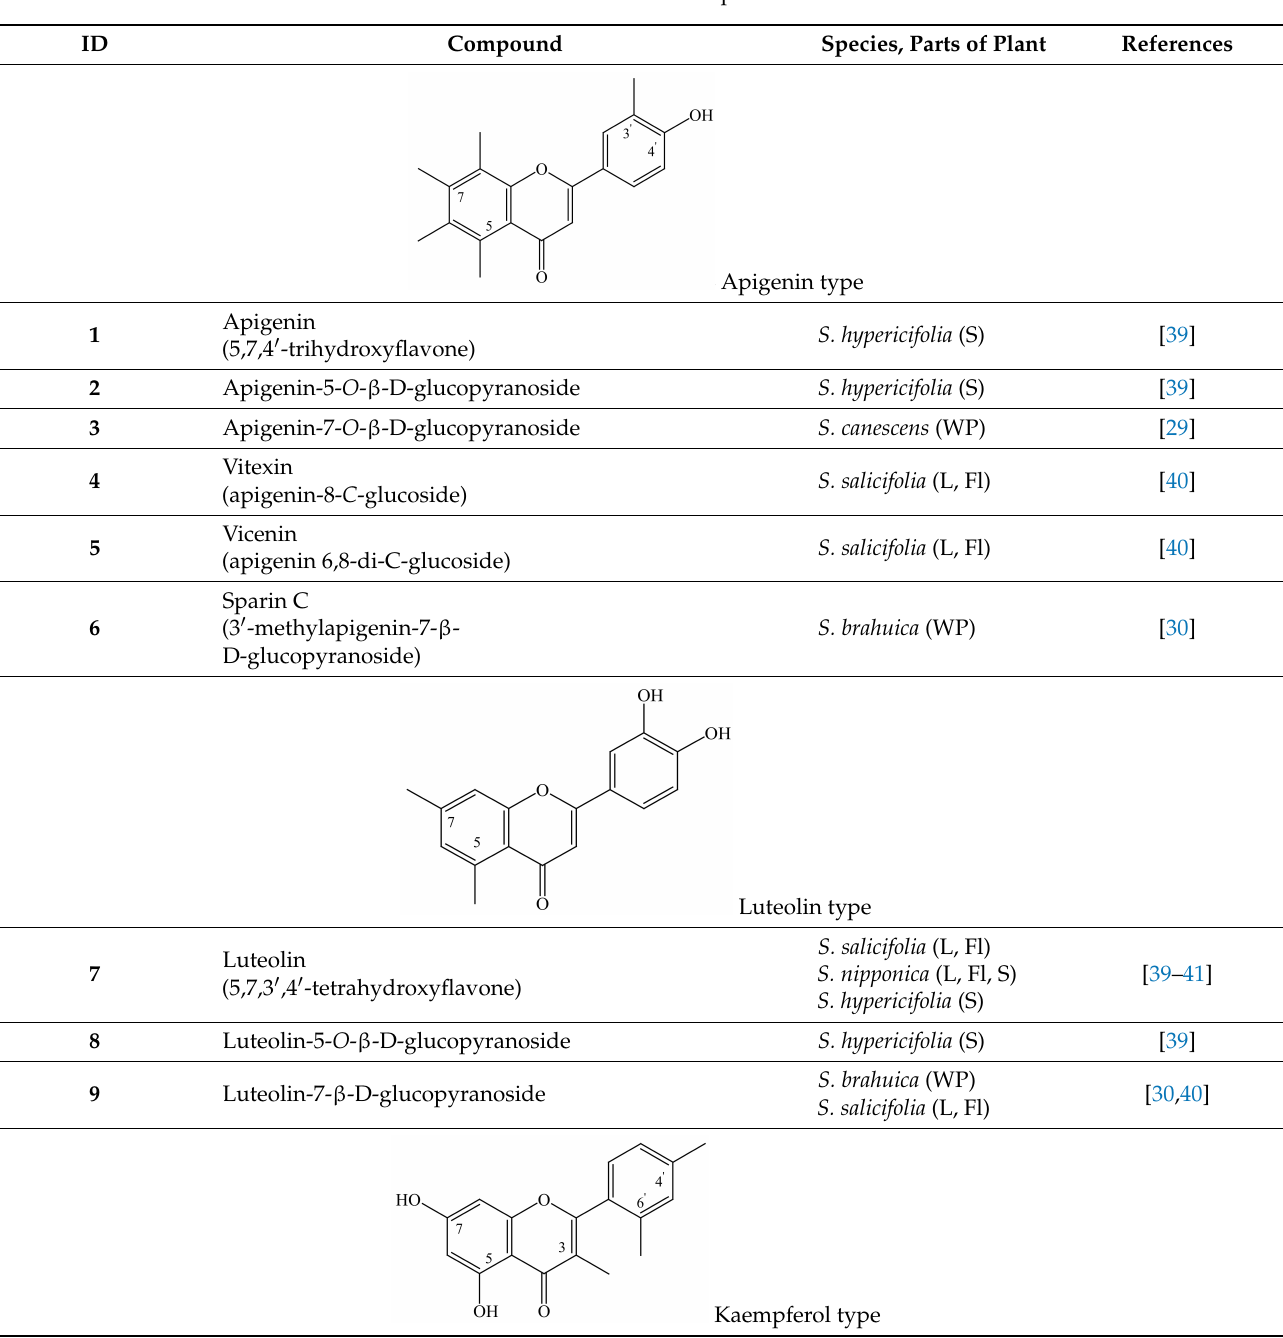
Table 1. Flavonoids of